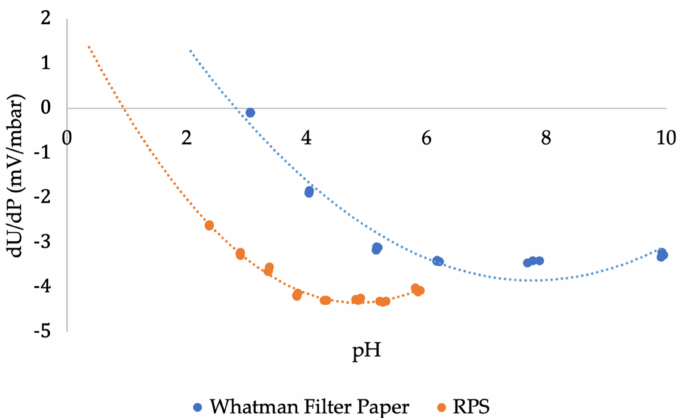
Figure 9. Streaming potential coupling coefficient (dU/dP) of Whatman filter paper and RPS. Dashed lines represent an extrapolation simulating the isoelectric point (IEP).